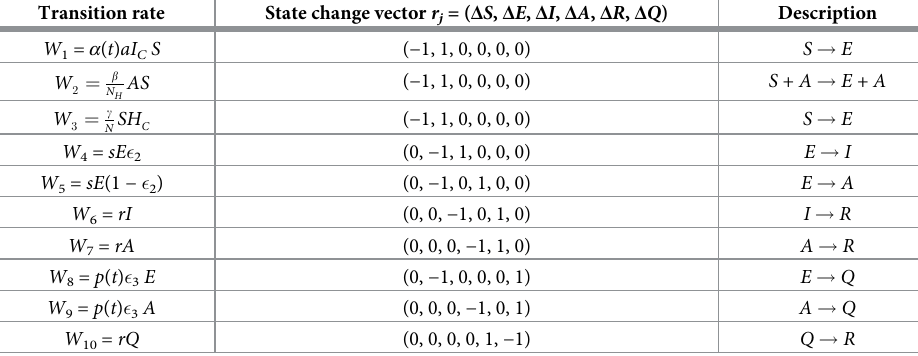
Table 1. Reaction rates of the stochastic dynamics described by Eq